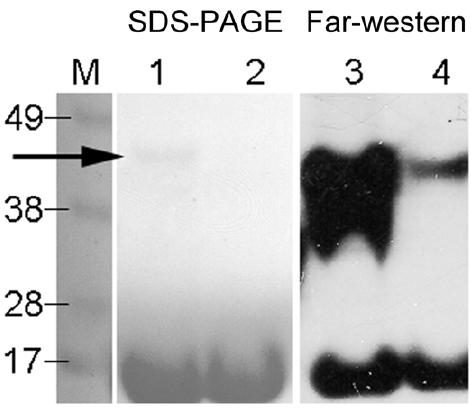
Figure 8. Far-western of purified yp Tpx. SDS-PAGE and Coomassie staining of: lane M, molecular weight ladder; lane 1, yp Tpx; lane 2, yp TpxC61S and (lanes 3 and 4 respectively) far-western of: yp Tpx and yp TpxC61S probed with ME0052-bio. The arrow highlights the presence of a small amount of dimeric yp Tpx on the SDS-PAGE, which can be contrasted with the far stronger signal from the corresponding band on the far-western.